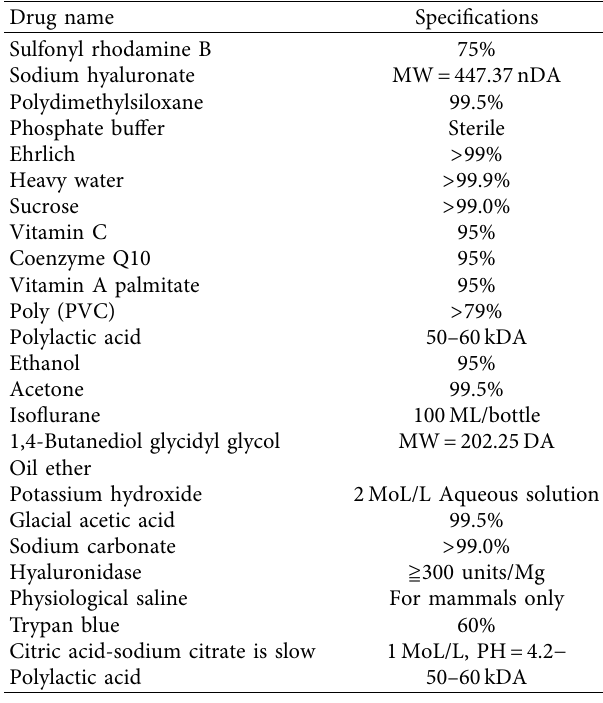
Table 1: Names and specifications of used pharmaceutical reagents.